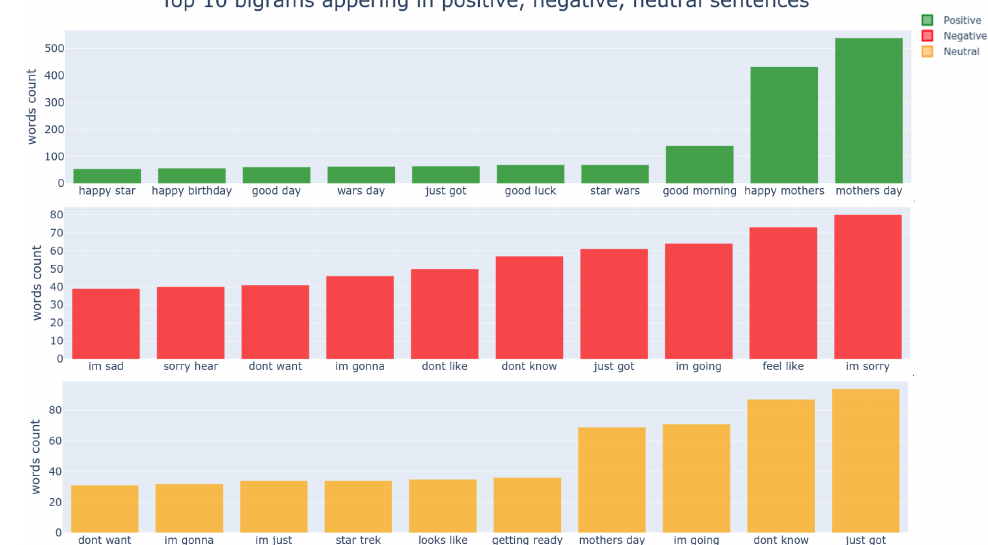
Figure 10. Top 10 bigrams appearing in positive, negative, neutral sentiment. By looking at top tier bigrams, they demonstrate better discrimination between sentiment than